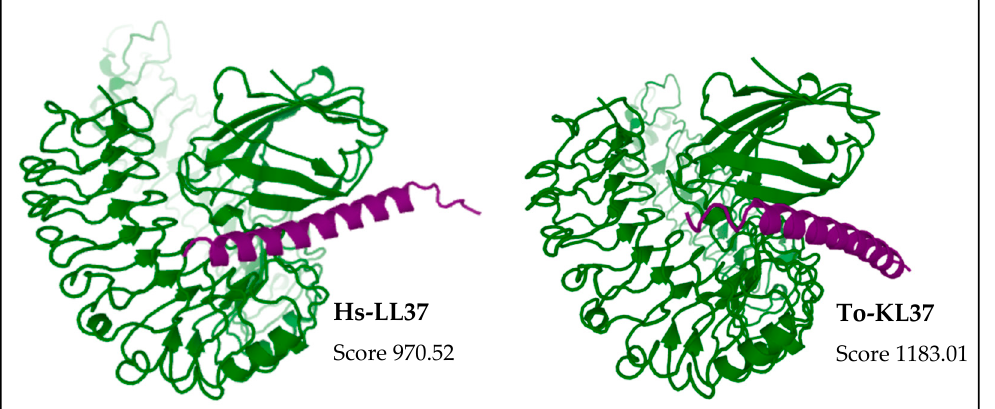
Figure 9. Molecular docking between the complex of murine TLR4/MD2 (PDB accession 2Z64) and the Alphafold model of the putative cathelicidin peptide of the Iberian mole ( Talpa occidentalis ). The human cathelicidin peptide Hs-LL37 was similarly used as a reference peptide. The analysis of the molecular interaction was performed by the GalaxyTongDock_A web server (https://galaxy.seoklab.org/index.html accessed on 9 May 2022). Purple protein corresponds to the peptide and green protein corresponds to the TLR4/MD2 complex. The final models were obtained by clustering similar model structures. They were ranked by the cluster size (or score when the interface option is used). The model with highest TongDock_A score was chosen for the analysis of the interaction. The GalaxyTongDock score has the same absolute value as the GalaxyTongDock energy but with the opposite sign).